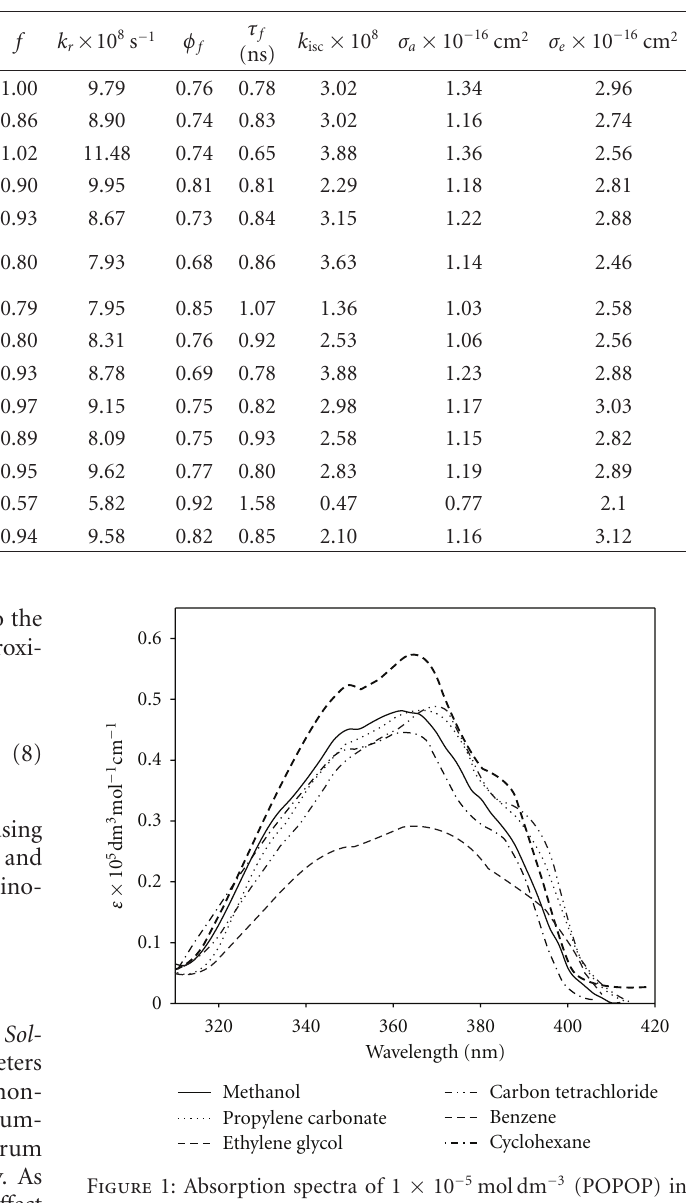
Table 1: Absorption and fluorescence properties of POPOP in di ff erent solvents.